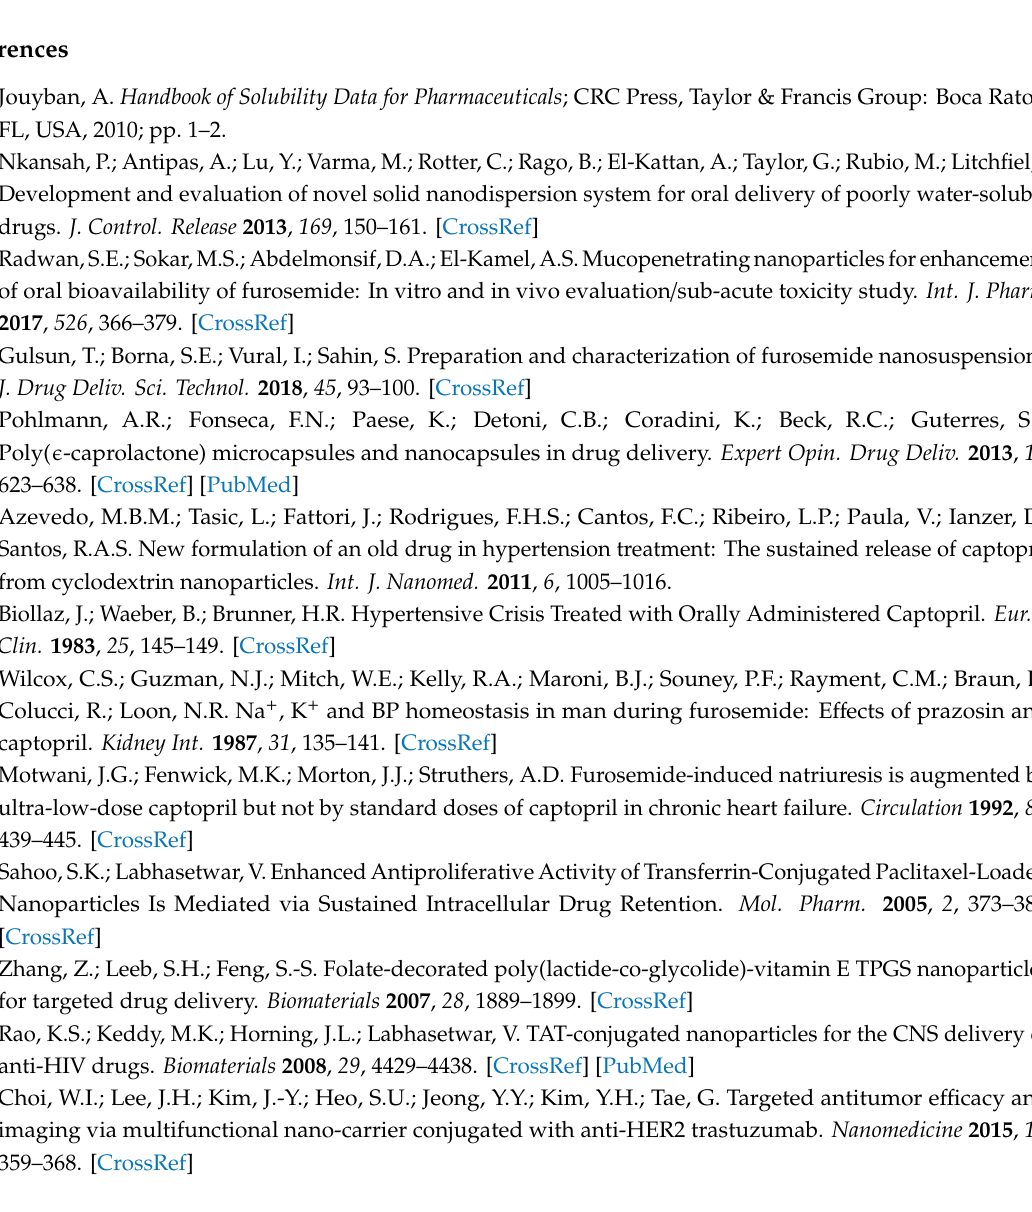
Figure S3: Physical stability evaluation of Capt(0.5)-Zn(25)-MLNC-Fur(0.45) by Multiple Light